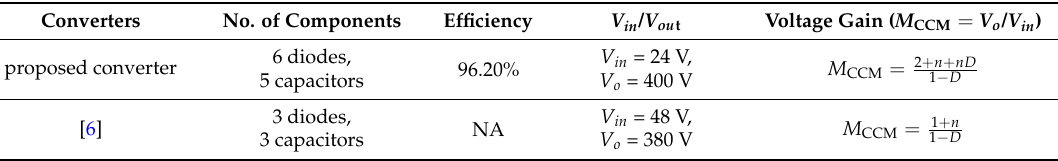
Table 1. Comparison of the proposed converter compared with some of the previous converters. NA: Not showing efficiency in reference